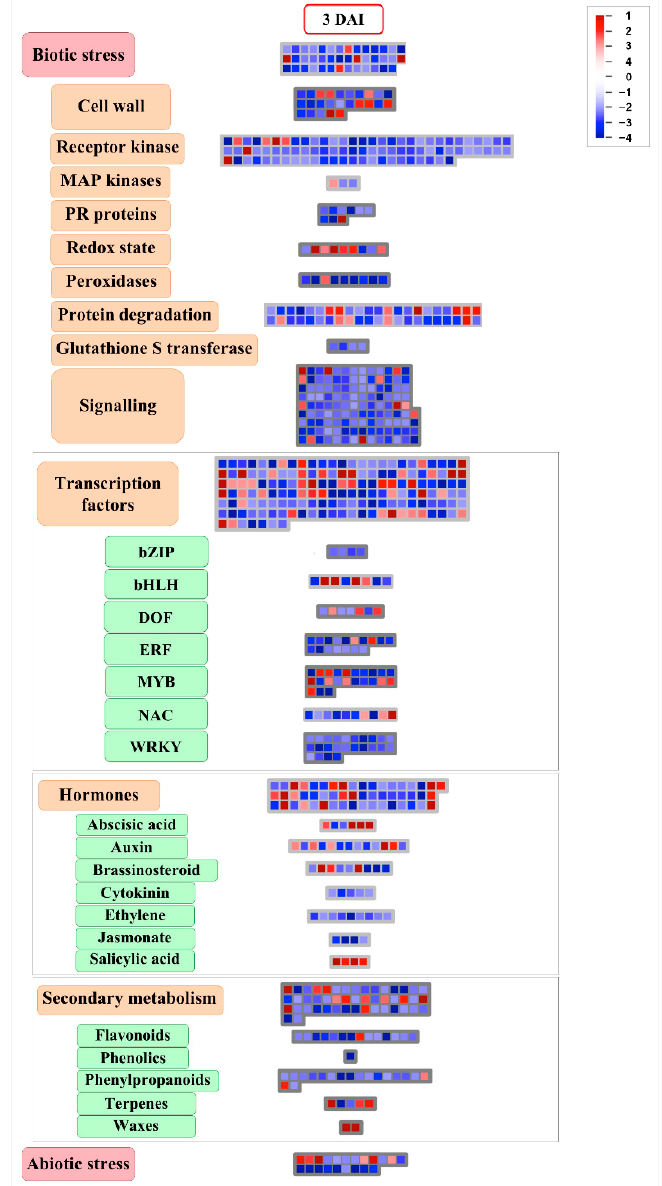
Figure 4. MapMan ontology-derived pictorial overview of expression profiles for differentially expressed genes in Musa acuminata var. Calcutta 4, 3 days after inoculation with Pseudocercospora musae . Differential expression data based on log2FC of transcripts from inoculated plant tissues versus non-inoculated controls are presented across selected pathways, with each point representing a paralog gene encoding a specific enzyme within the metabolic pathway. A red color indicates an up-regulated gene in infected Musa leaf tissue versus non-inoculated controls, whereas a blue color indicates down-regulation.